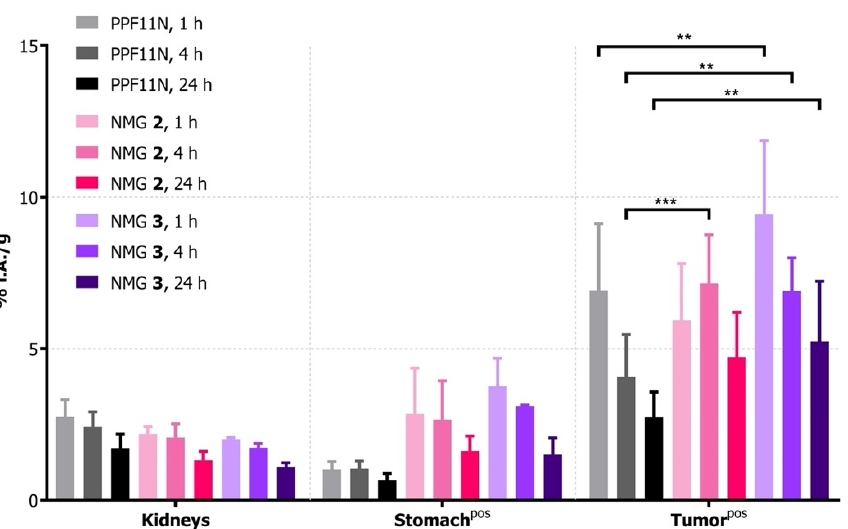
Figure 4. Biodistribution of 177 Lu-labeled conjugates in relevant organs (kidneys and stomach) and CCK2R-positive tumor xenografts at 1, 4, and 24 h p.i. ** p ≤ 0.002, *** p < 0.001. Injections: 10 pmol, 100 µL, 0.1 µM, 0.5 MBq, 1 µg/kg. n = 4 animals per group (for complete tables of biodistribution